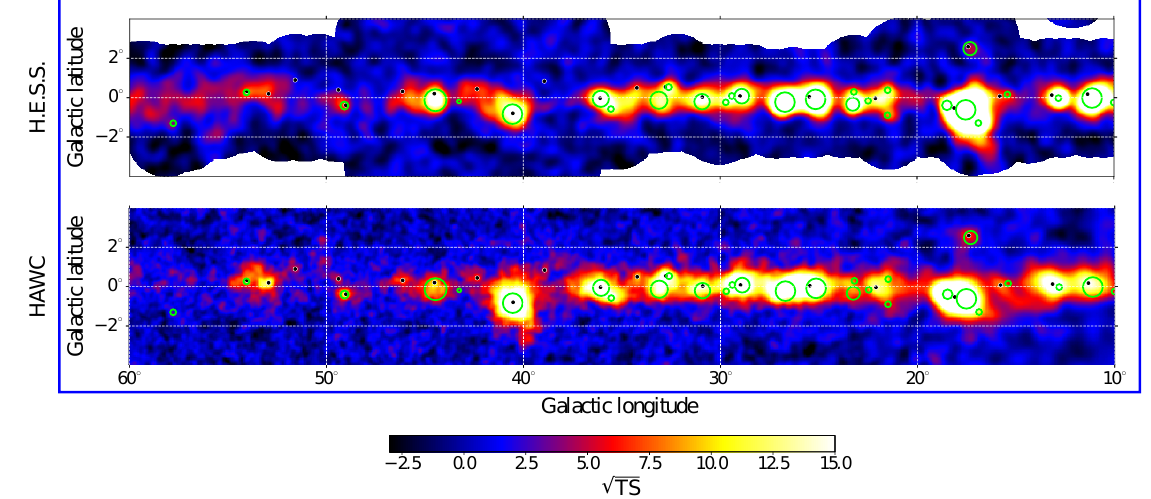
Figure 16. The galactic plane as see by H.E.S.S. and HAWC with the same angular resolution. Adapted from